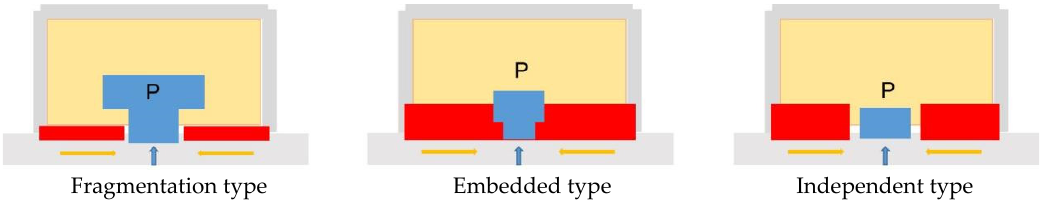
Figure 15. Characteristics of the external environment of urban parking facilities.